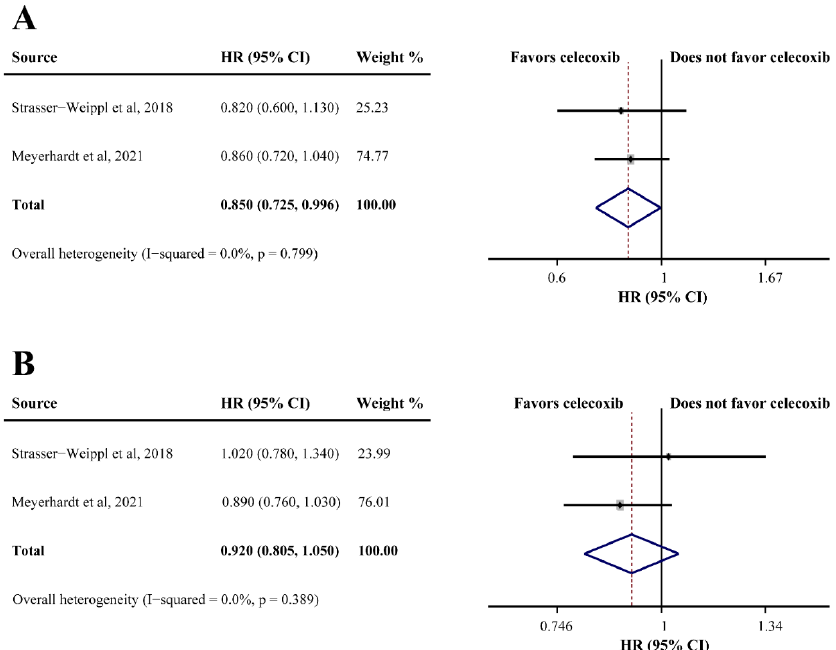
Figure 4. Efficacy of celecoxib-combined adjuvant therapy on overall survival (OS) ( A ) and disease- free survival (DFS) ( B ). HR: hazard ratio; CI: confidence interval [32,47].